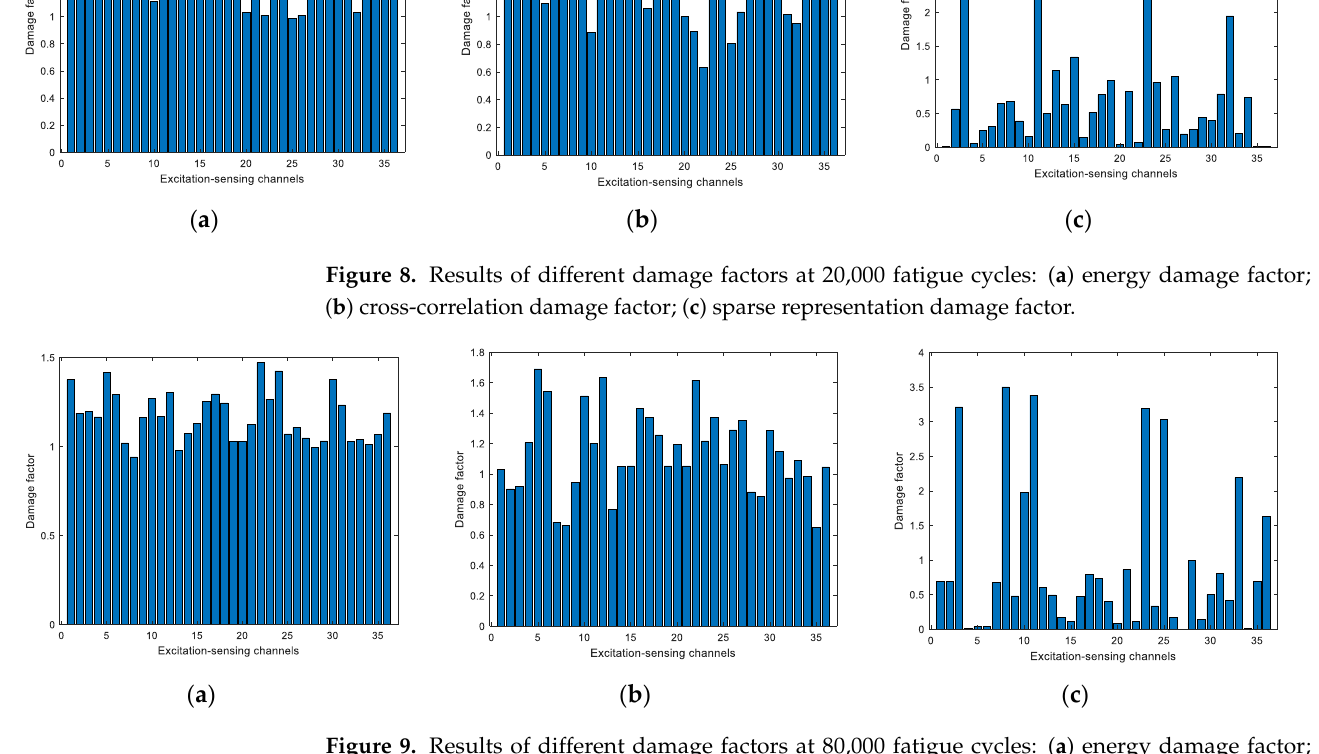
Figure 9. Results of different damage factors at 80,000 fatigue cycles: ( a ) energy damage factor; ( b ) cross-correlation damage factor; ( c ) sparse representation damage